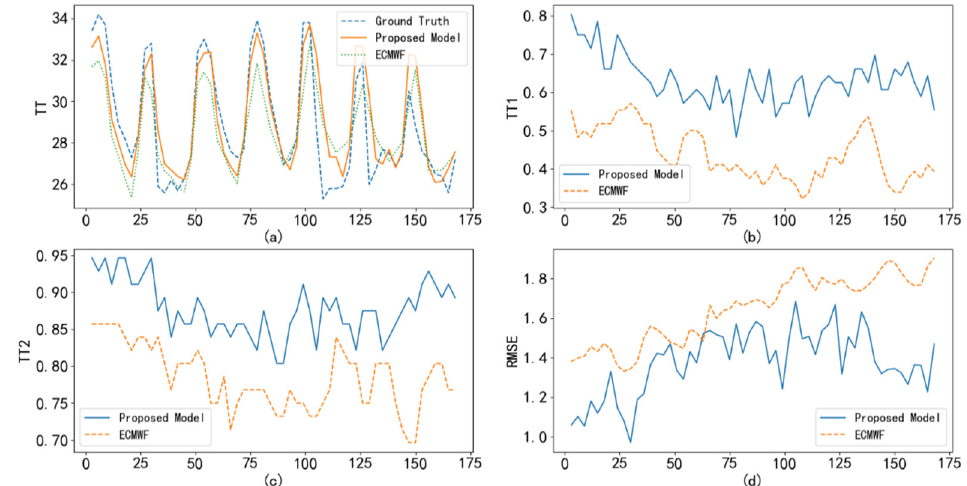
Figure 5. Comparison of the ECWMF model and the proposed method in terms of their temperature forecast at Haikou Station: ( a ) real temperature versus ECWMF prediction and proposed correction; ( b ) TT 1 index comparison; ( c ) TT 2 index comparison; ( d ) RMSE index comparison.